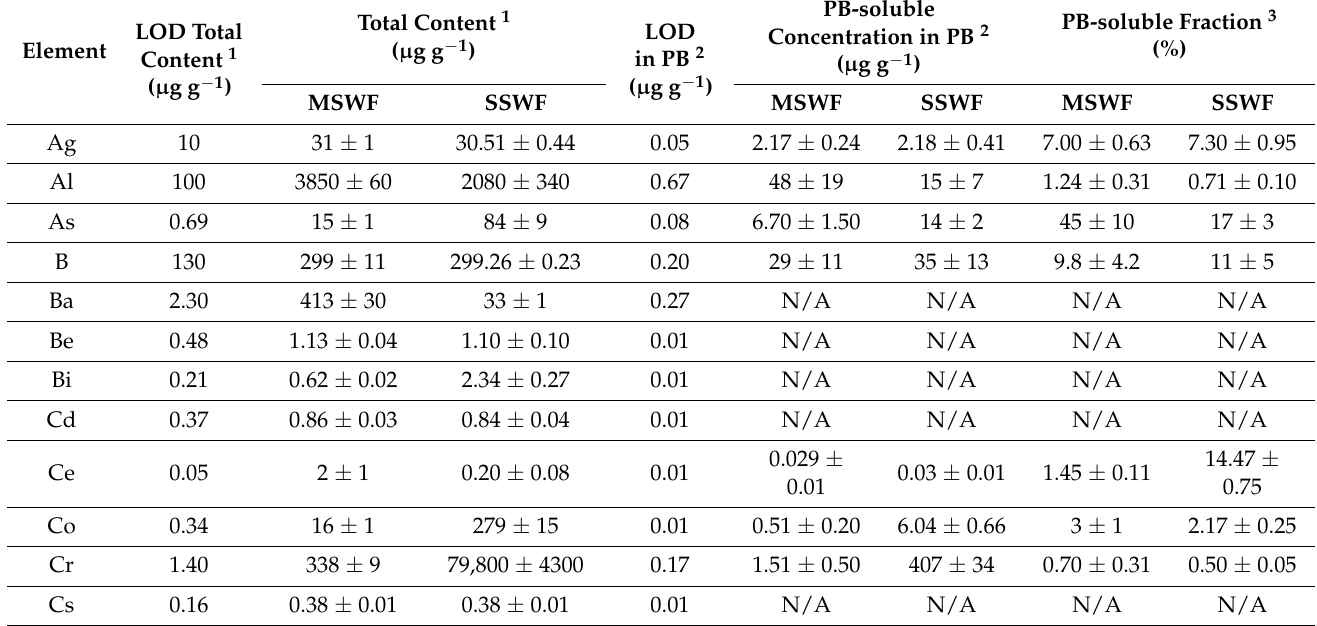
Table A5. Total content ( µ g g − 1 ), PB-soluble concentration ( µ g g − 1 ), and PB solubility (%) obtained for all the elements analyzed in two welding fume reference materials (SSWF-1 and MSWF-1) after 24-h extraction in PB (average ± σ , n = 9